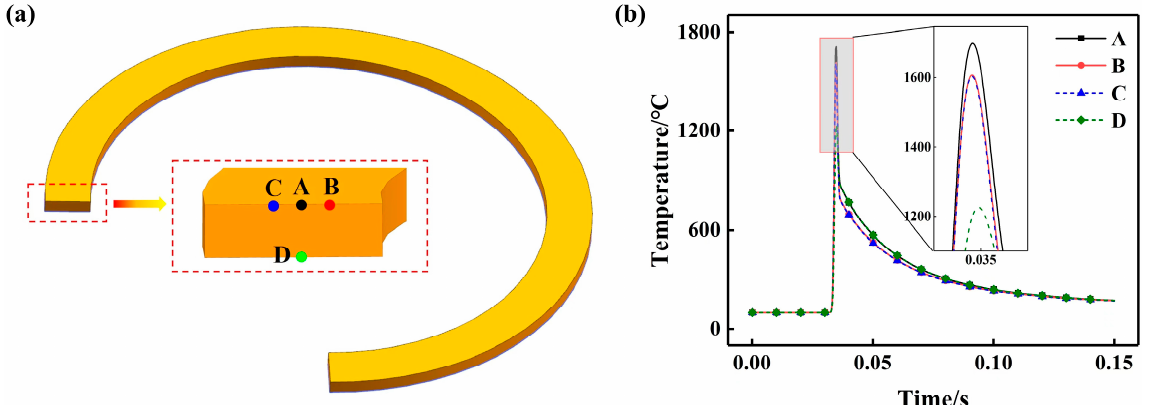
Figure 6. The temperature changes with time at different points on the longitudinal section: ( a ) the distance from point A to point B is 0.1 mm, the distance from point A to point C is 0.1 mm, the distance from point A to point D is 0.03 mm, and ( b ) temperature curve over time.